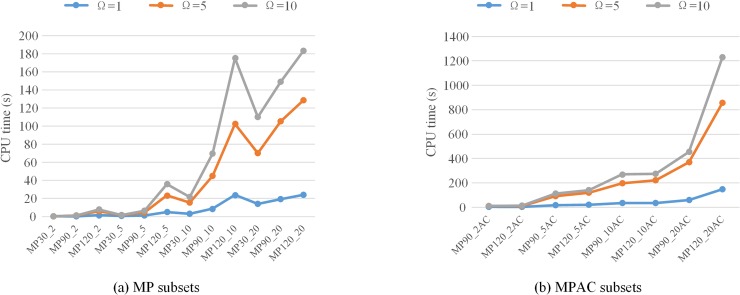
Comparison of CPU time of MP subsets and MPAC subsets.